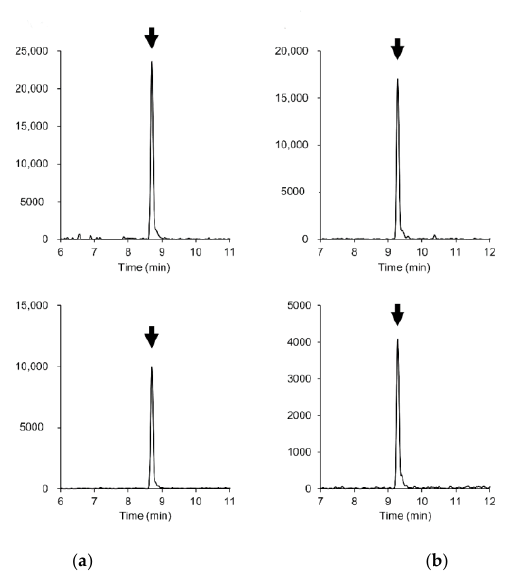
Figure 2. Extracted ion chromatograms (mass window ±5 mDa) of parent and fragment ions of ( a ) boscalid and ( b ) cyazofamid in 0.01 mg/kg-spiked soybean blank extract. Upper plots: [M + H] + (( a ) m/z 343.0399, ( b ) m/z 325.0521). Lower plots: fragment ions (( a ) m/z 307.0633, ( b ) m/z 108.0114).